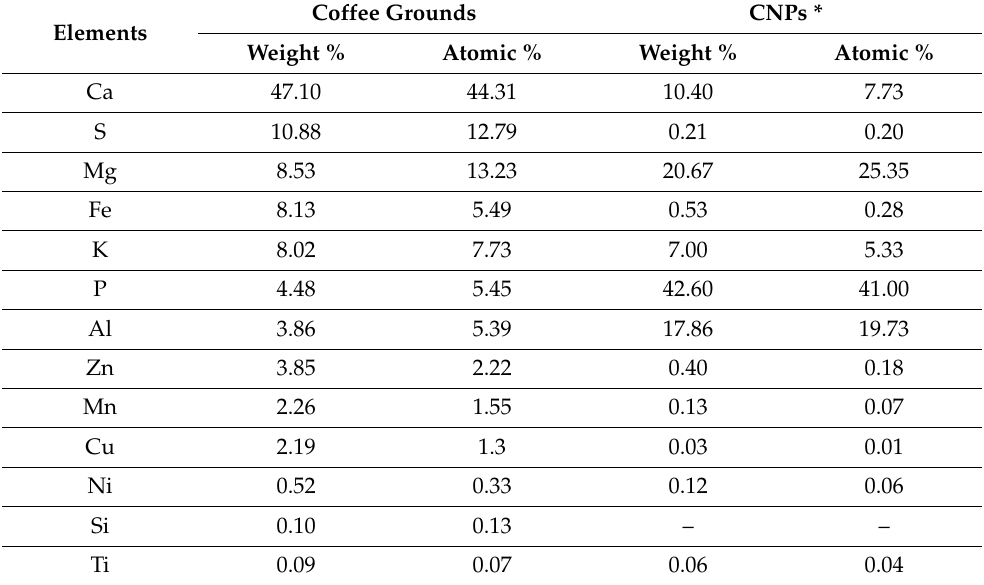
Table 1. Elemental composition of the coffee grounds and CNPs quantified from the XRF measurement.